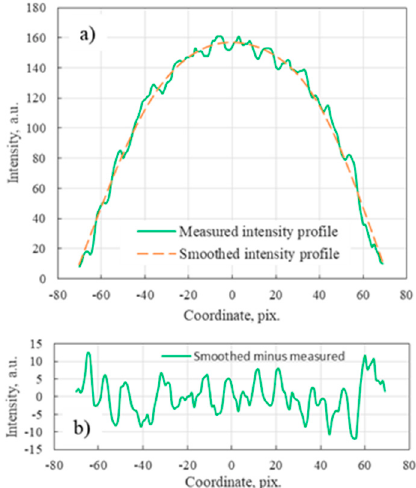
Figure 2. Illustration of the irregularity coefficient calculation: ( a ) original and smoothed intensity distribution in the NFIP cross section and ( b ) their difference.